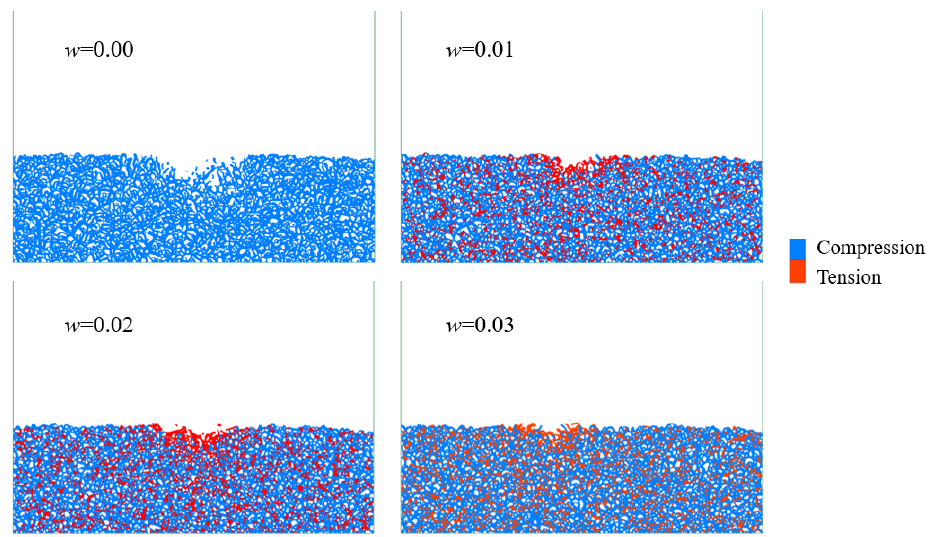
Figure 6. The distribution of force chains among sand grains in the sand-bed collision under different surface moisture in times of 0.15 s ( V in = 5m/s). Force chains are represented as lines and the colour indicate the form of forces.